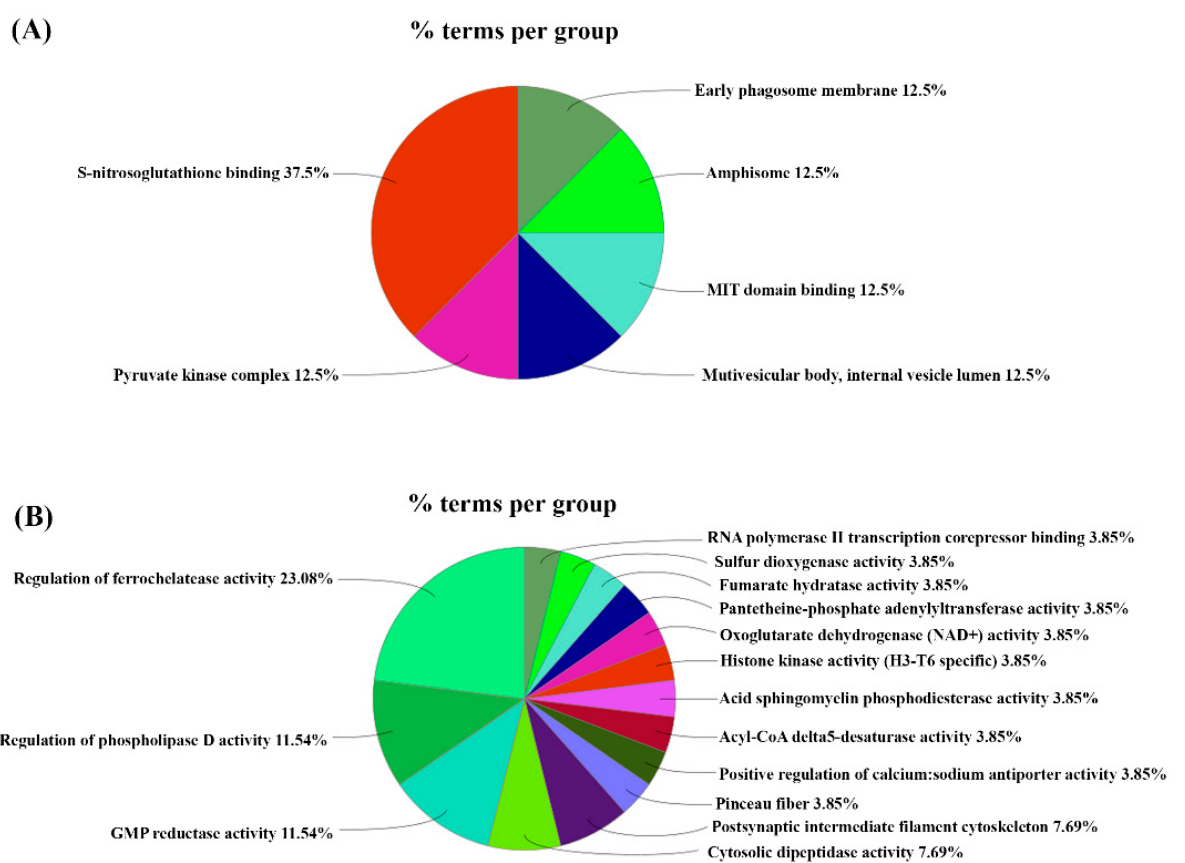
Figure 2. ClueGO analysis. Mapping of ( A ) upregulated and ( B ) downregulated molecular functions and biological processes .